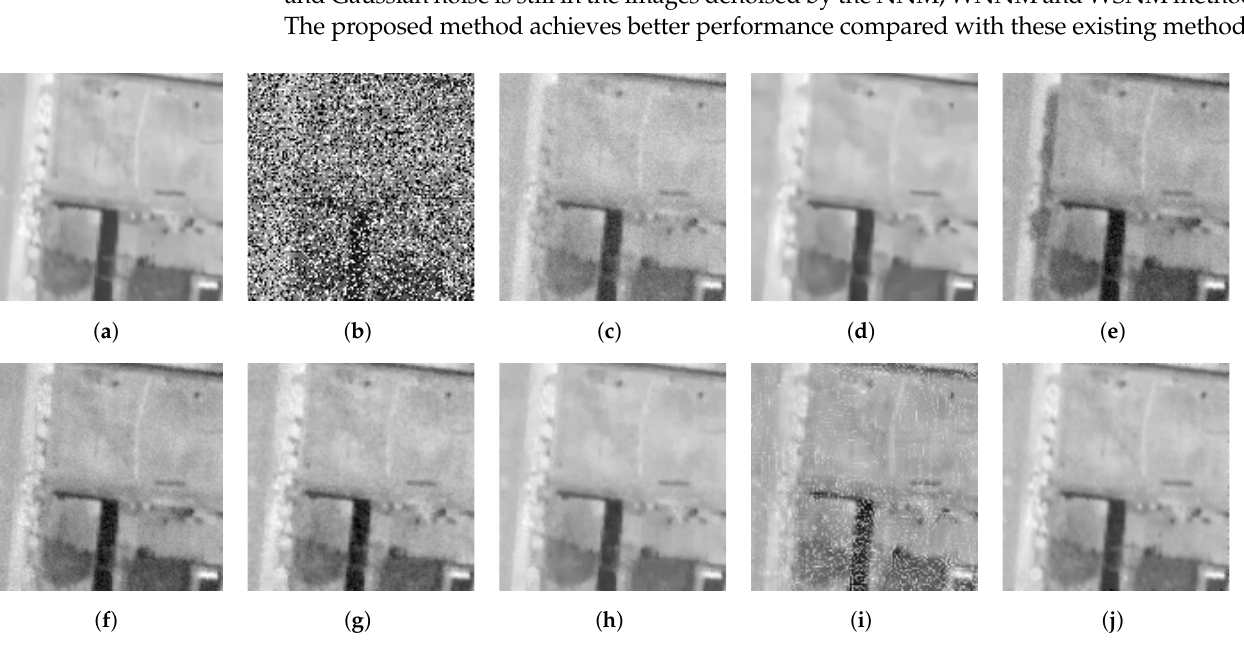
Figure 7. Case 3: The comparison of HSIs denoising results with existing methods on the SFD dataset: ( a ) ground truth of band 35; ( b ) noisy image; ( c ) NNM; ( d ) BM4D; ( e ) WNNM; ( f ) WSNM; ( g ) LRTDTV; ( h ) 3DTV; ( i ) FastHyDe; and ( j ) the proposed